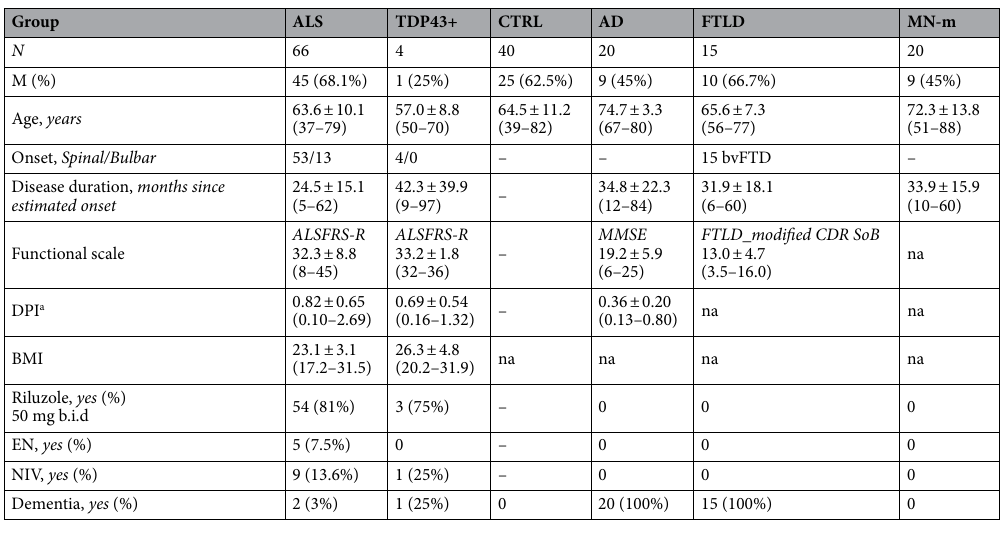
Table 1. Clinical and demographic characteristics of the recruited sample. AD Alzheimer’s disease, ALSFRS-R ALS Functional Rating Scale-revised version, BMI body mass index, CTRL controls, DPI disease progression index, EN enteral nutrition, MMSE Mini-Mental State Examination, na not available, NIV non-invasive ventilation, TDP43 + ALS patients carrying a pathogenic TARDBP mutation. Data are shown as mean ± SD. a The DPI was calculated as [48-ALSFRS-R score]/disease duration (months) for ALS patients and [30-MMSE score]/disease duration (months) for AD